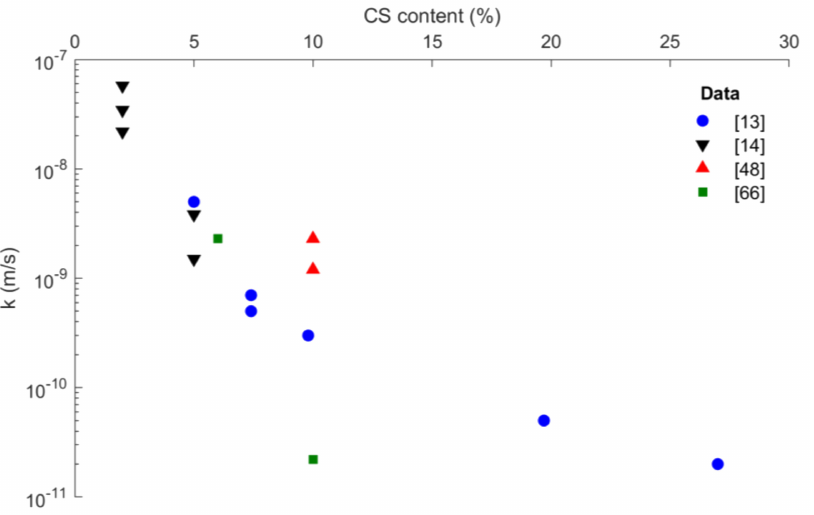
Figure 14. Hydraulic conductivity versus colloidal silica content for different CS-treated materials (data collected from references in the legend; data for Monterey 0/30 sand for [13]).